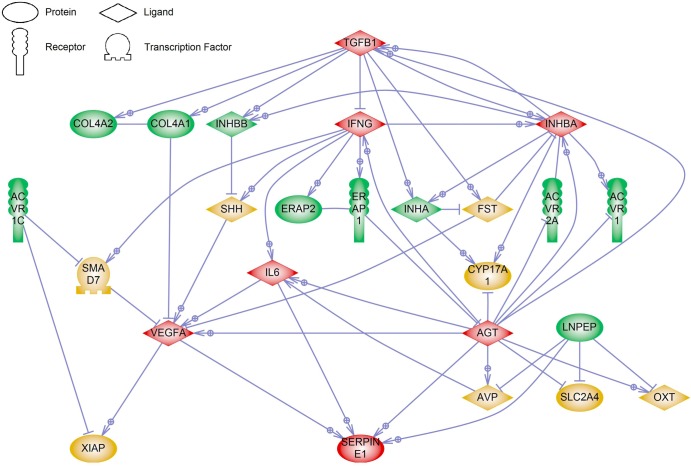
Common regulators and targets of maternal PE susceptibility genes.A gene network showing the interactions between the maternal PE susceptibility genes was generated with Pathway Studio 9.0. Each link is supported by at least one published reference. Maternal PE susceptibility genes investigated are coloured in green, connecting genes in yellow and major regulator/target genes in red.